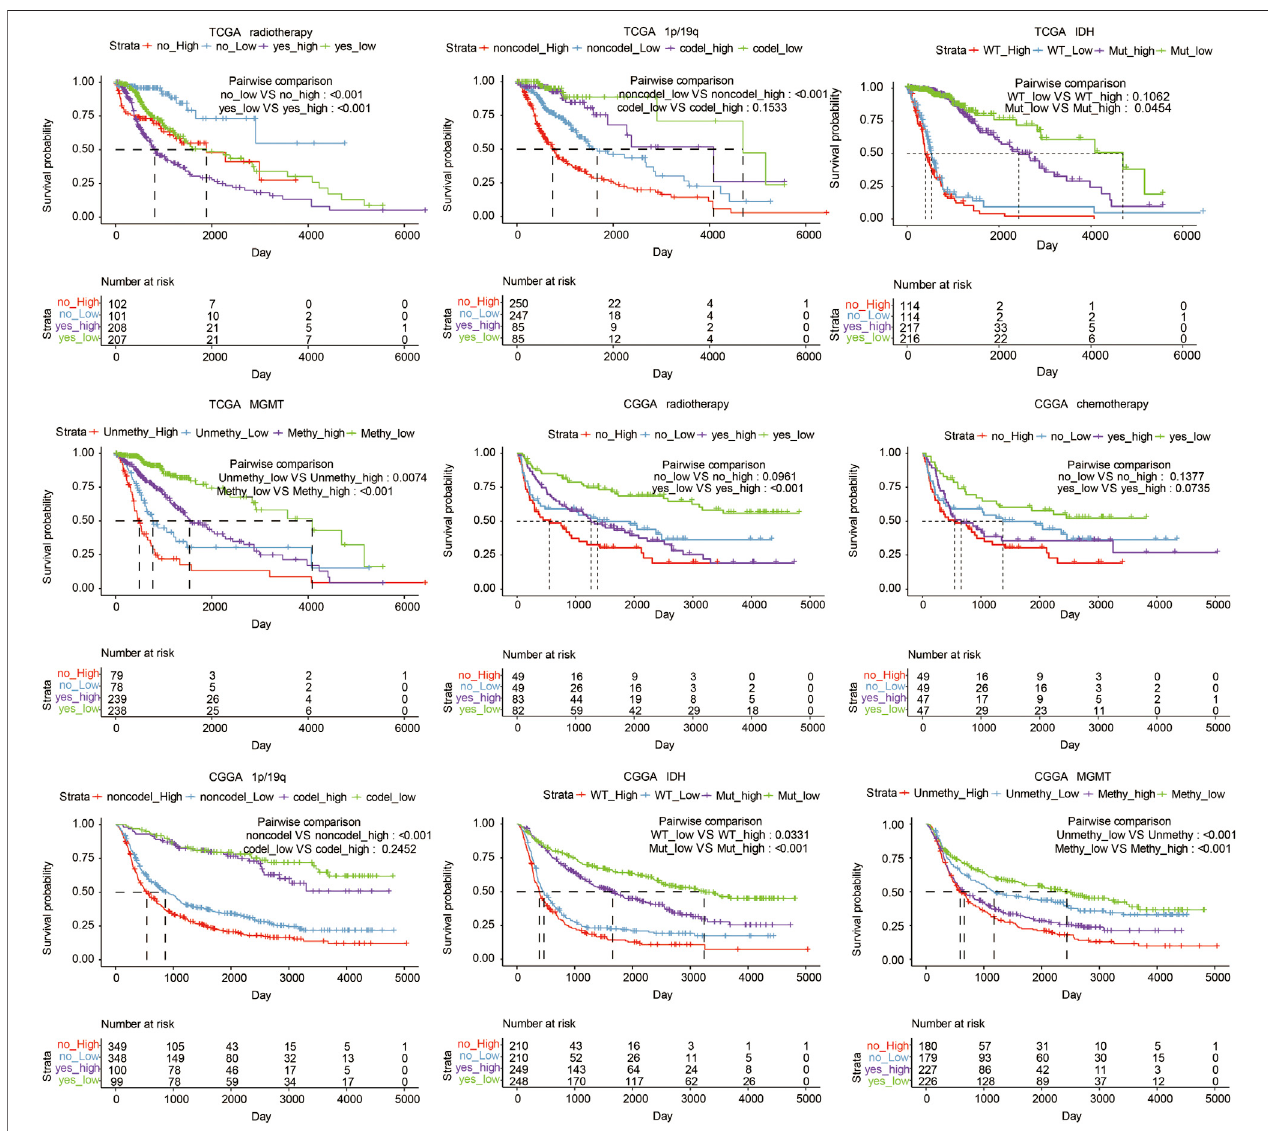
FIGURE 3 | Overall survival in glioma patients with different status, including radiotherapy, chemotherapy, 1p19q, MGMT, and IDH in TCGA and CGGA datasets.